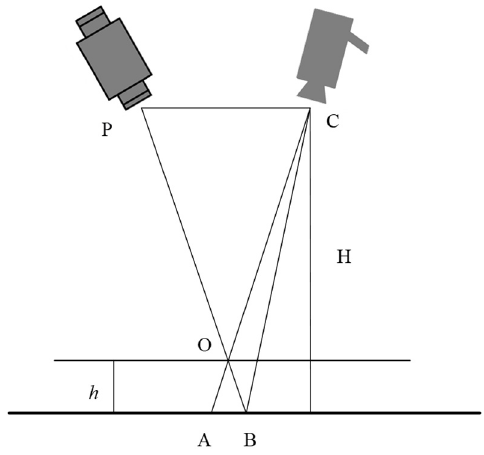
Figure 2. The optical principle of the thickness position conversion.